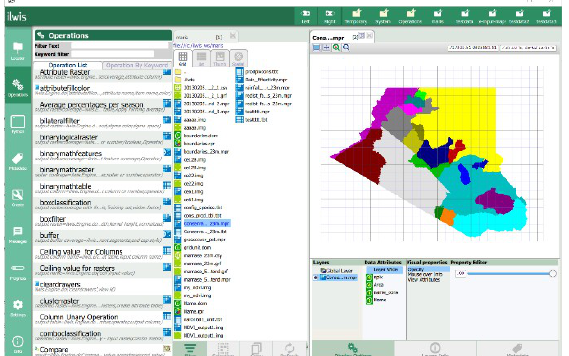
Figure 1. User Interface of the ILWIS desktop, showing its operation and data pane and the map with conservancies in the Maasai Mara in Kenya, the use case focus of this paper (see Section